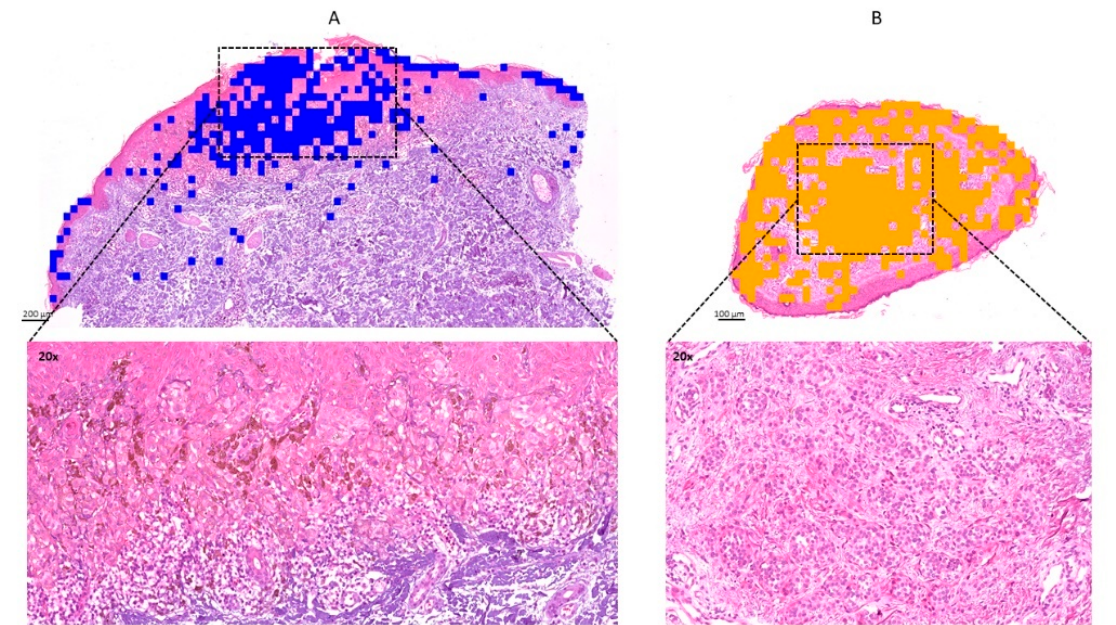
Figure 4. Correlation of imaging mass spectrometry (IMS) classification and histology. ( A ) Hematoxylin and eosin staining overlay with IMS classification (pixel spots in blue) of a melanoma sample. ( B ) Hematoxylin and eosin staining overlay with IMS classification (pixel spots in yellow) of a nevus case. Square dashed lines represent the pathological annotated areas that correlate with the IMS classification. Images at 20× magnification view are shown for malignant melanoma ( A , down) and melanocytic nevi ( B , down).